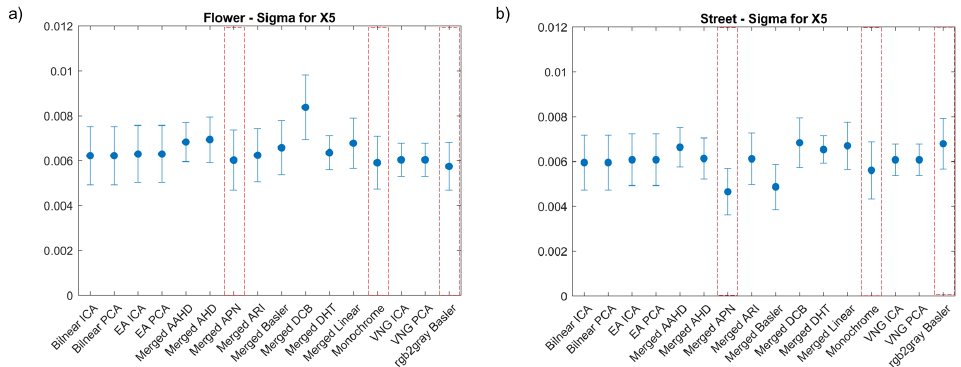
Figure 5. Correlation coefficient (sigma) maps corresponding to X5 shift for: ( a ) Flower and ( b ) Street paintings. Red boxes indicate the selected methods.